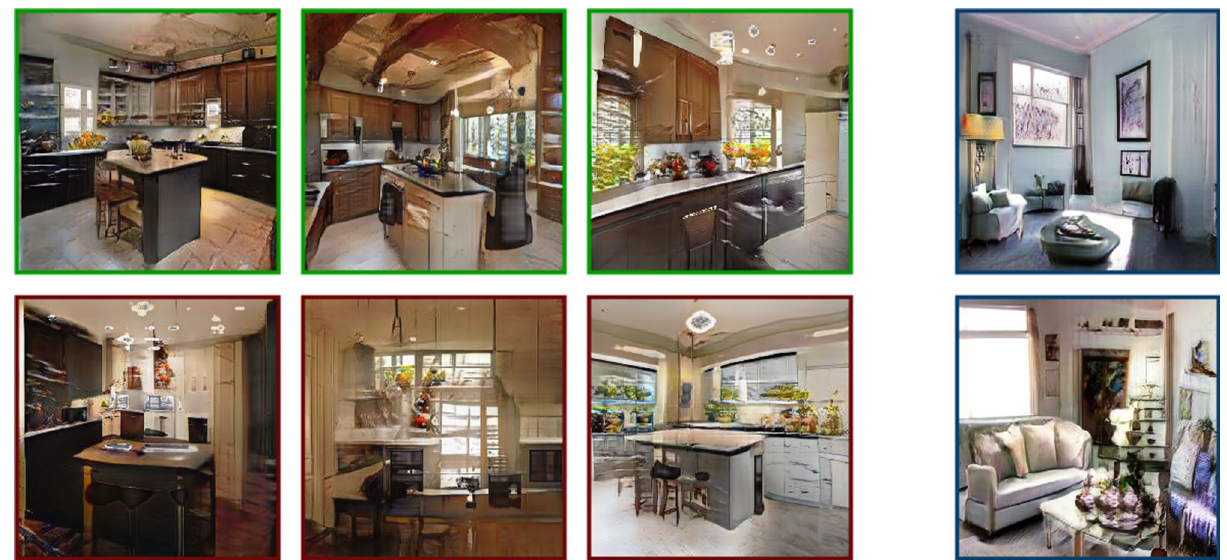
Figure 5. Memorable, shown within green boundaries and non-memorable, shown within red boundaries generated image pairs. Foils are shown within blue